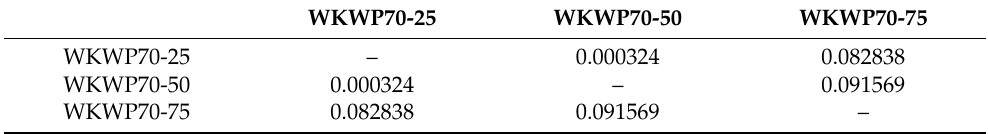
Table 7. Results of Tukey’s post hoc test for the WKWP group of dies.